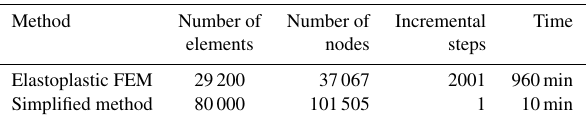
Table 3. Comparison for elastoplastic FEM and simplified defor- mation simulation